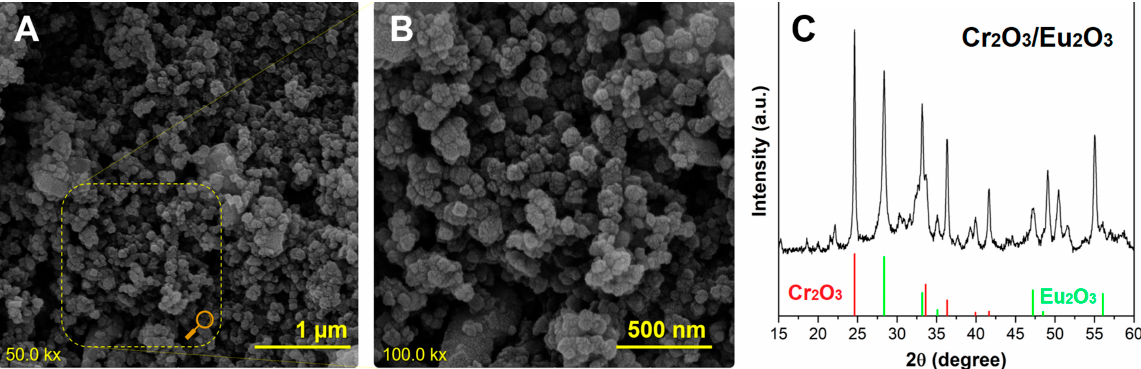
Figure 1. FE-SEM micrographs of cauliflower-like Cr 2 O 3 /Eu 2 O 3 ( A ) magnification 50 kx, ( B ) 100 kx and ( C ) X-ray diffraction pattern of the prepared nanocomposite. As a reference, the patterns of standard Cr 2 O 3 (JCPDS #96-210-4123) and Eu 2 O 3 (JCPDS #96-101-1288) were given below the sample pattern.